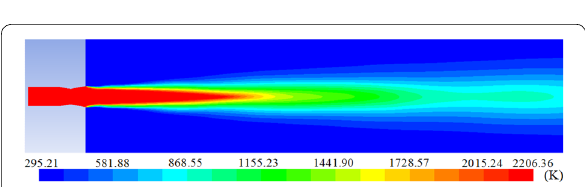
Figure 13 Total temperature contour of gas jet from a single